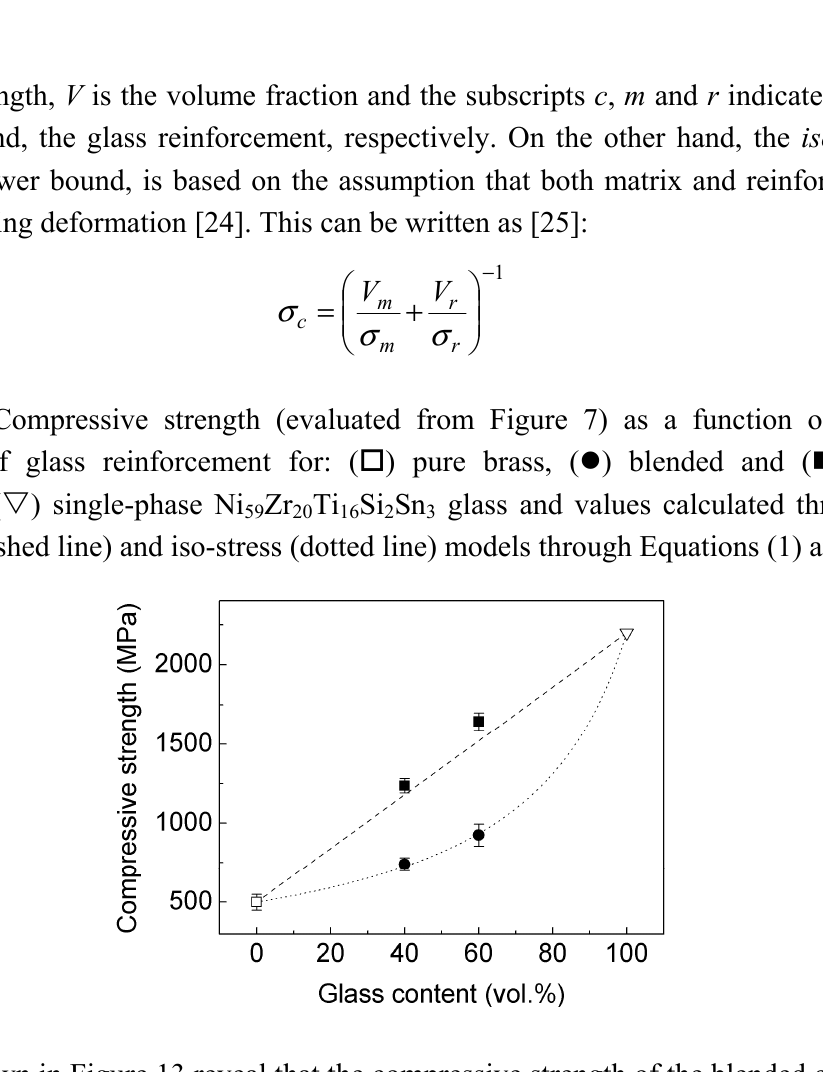
Zr Ti Si Sn glass and values calculated through the 59 20 16 2 3